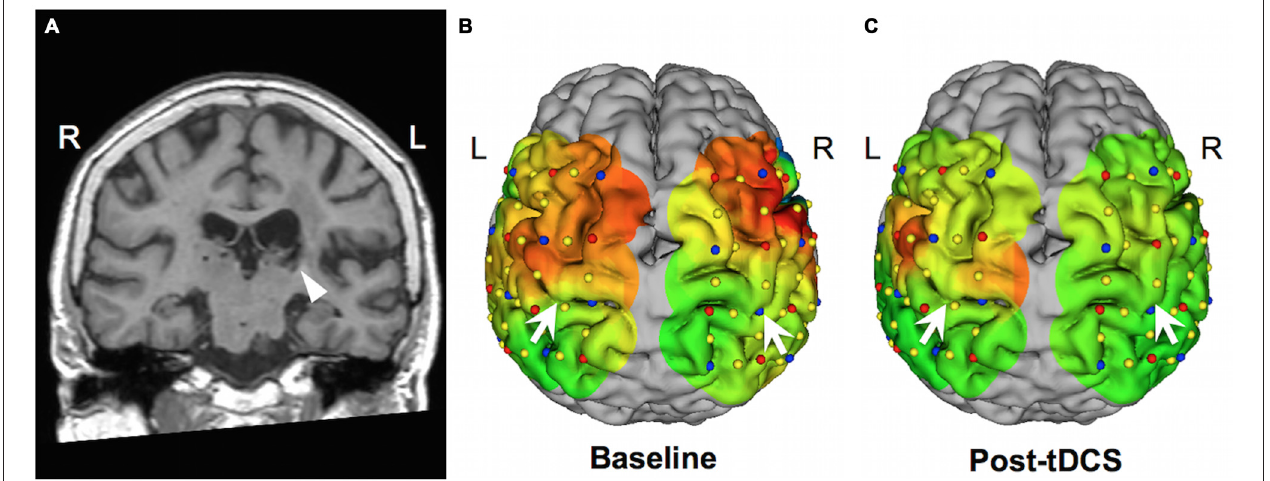
FIGURE 2 | Neuroimaging studies in case 1. (A) Coronal view of a T1-weighted image. The arrow indicates a post-hemorrhagic lesion in the left thalamus. (B,C) Functional near infrared spectroscopy (fNIRS) results showing oxyhemoglobin level mapping during a right fist closure and opening task over a 3-D reconstructed image of the patient’s brain. Red and green indicate higher and lower functional activity levels, respectively. Arrows indicate the central sulci. Following all transcranial direct current stimulation (tDCS) sessions, activity in the right hemisphere was reduced. (This figure was adapted from Morishita et al. (2015b) with permission).